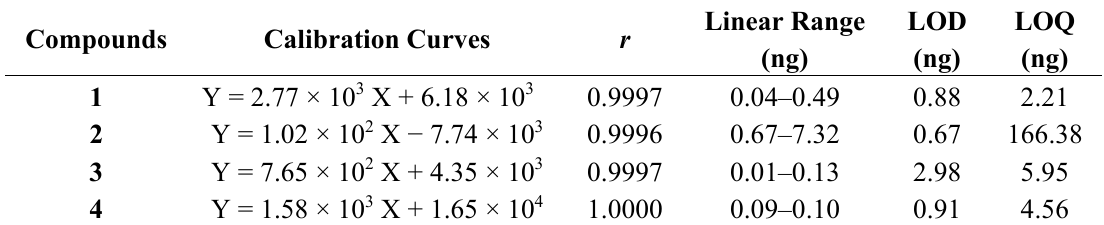
Table 2. Linearity, LOD, LOQ of tested compounds determined by the current method.